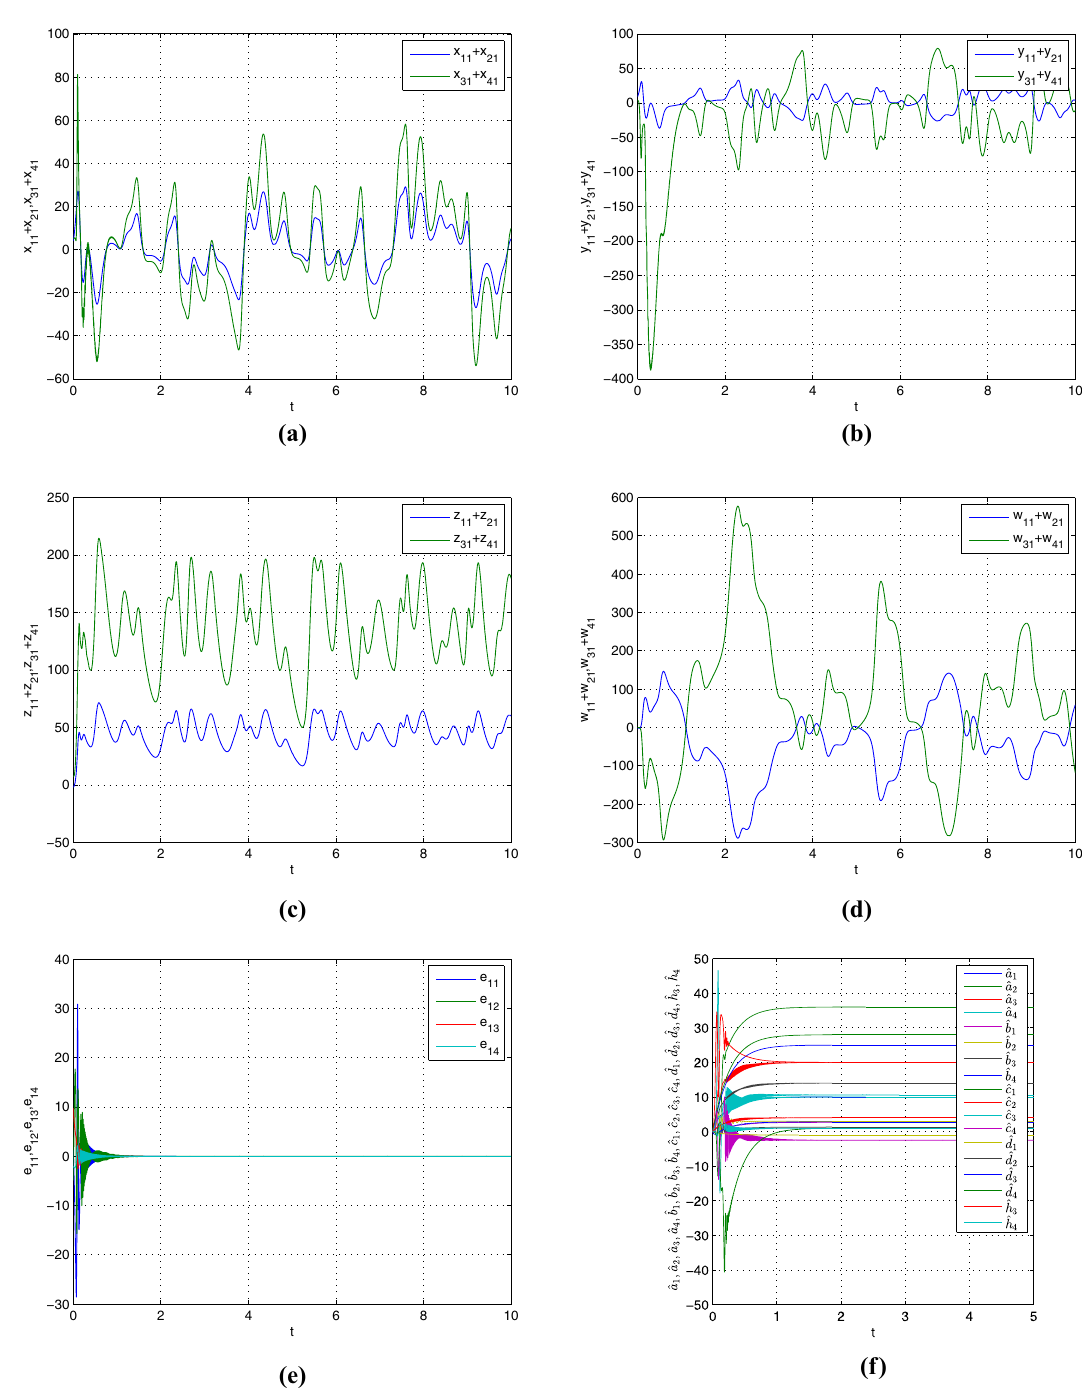
Fig.5 HPCCSofhyperchaoticsystems a between x 11 ( t ) + x 21 ( t ) and x 31 ( t ) + x 41 ( t ) , b between y 11 ( t ) + y 21 ( t ) and y 31 ( t ) + y 41 ( t ) , c between z 11 ( t ) + z 21 ( t ) and z 31 ( t ) + z 41 ( t ) , d between w 11 ( t ) + w 21 ( t ) and w 31 ( t ) + w 41 ( t ) , e HPCCS errors e 11 , e 12 , e 13 ,